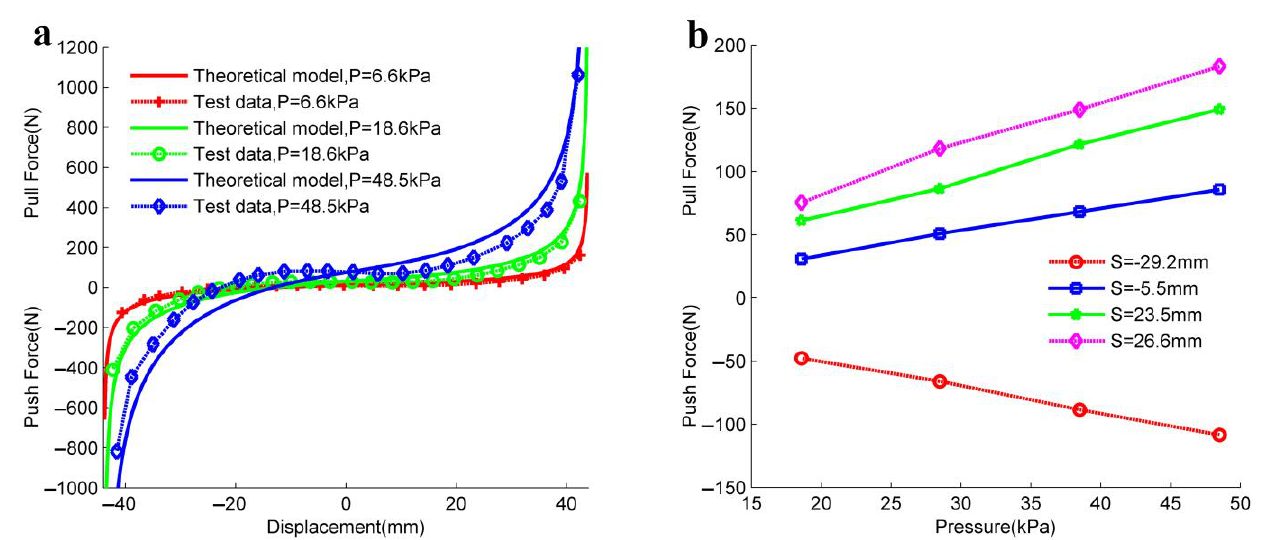
Figure 8. Test results of the actuator with a machined skeleton: ( a ) Force-displacement data; ( b ) Force-pressure data.